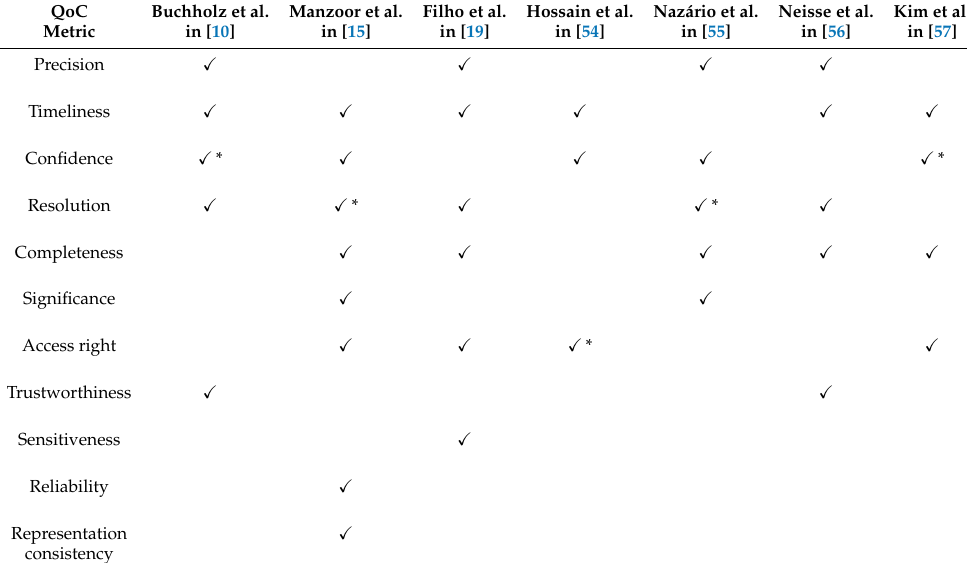
Table 4. The QoC metrics discussed in the literature. The first column represents the metrics, and the following ones represent the works. Each marked cell ( (cid:88) ) related to work indicates that the QoC metric in the same row is discussed in that work. The (*) following the check marks in cells indicates that the work defines the QoC metric with a different